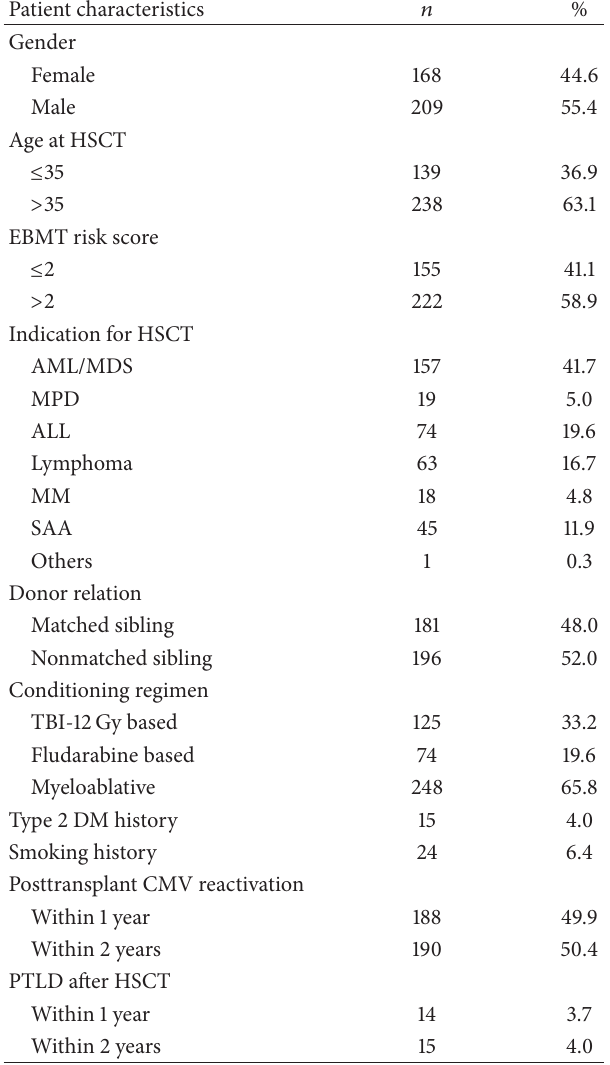
Table 1: Clinical characteristics of study patients ( 𝑛 = 377